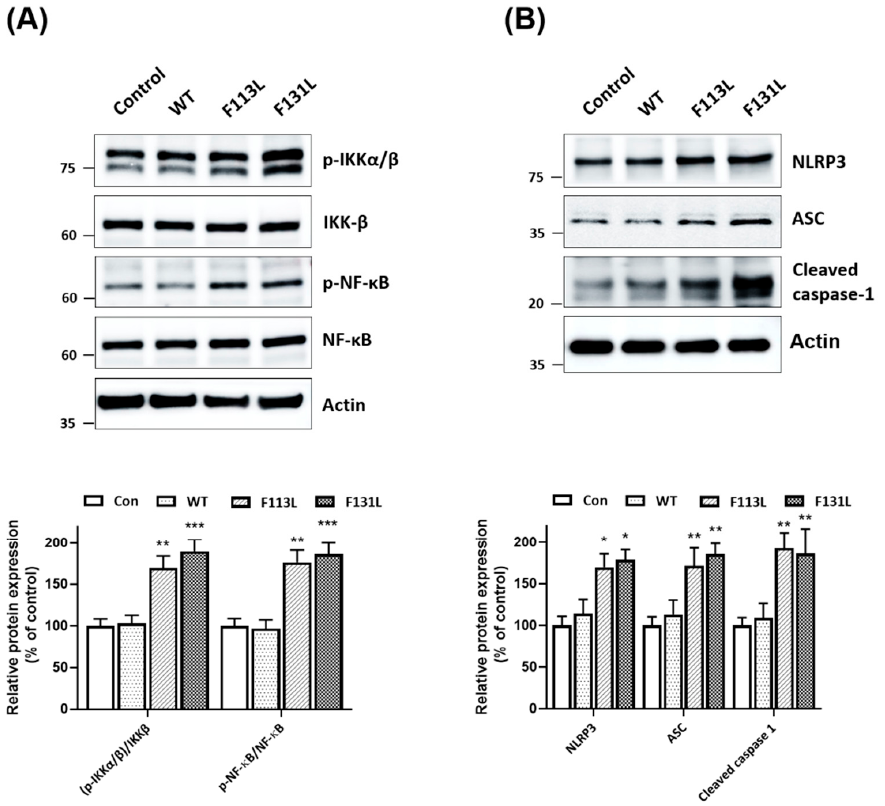
Figure 2. TOMM40 genetic variants induce activation of NF- κ B signaling and NLRP3 inflammasome in microglial cells. ( A ) Western blot analysis showed that expression of (F113L) or (F131L) TOMM40 induced activation of NF- κ B cascade by increasing protein expression of phospho-IKK α / β Ser176/180 and phospho-NF- κ B p65 Ser536 in BV2 microglial cells. ( B ) Compared with control or cDNA of WT TOMM40-transfected cells, transfection of cDNA encoding (F113L) or (F131L) TOMM40 caused activation of NLRP3 inflammasome by upregulating protein level of NLRP3 and ASC or cleaved caspase-1 in BV2 microglial cells. Each bar shows mean ± S.D. of four experiments. * p < 0.05, ** p < 0.01, *** p < 0.001 compared to control BV2 microglial cells.